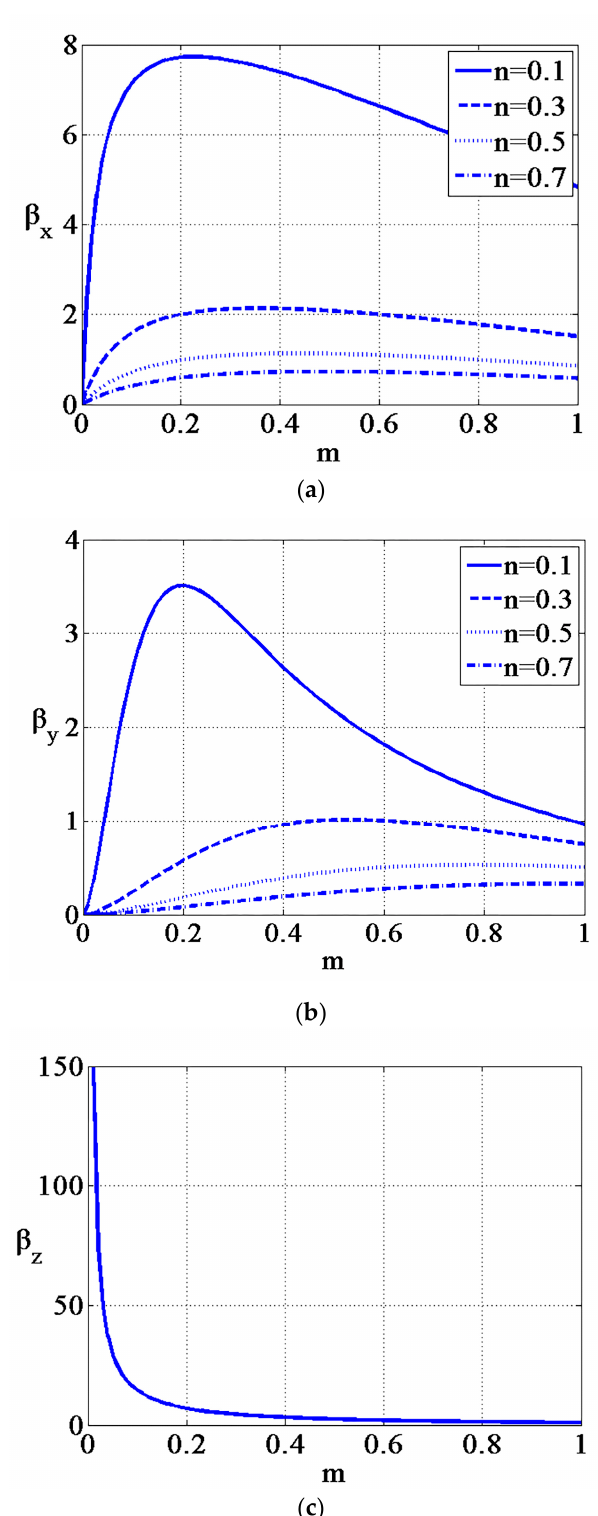
Figure 5. The relationship between parameters m , n , and the transfer coefficient: ( a ) the curve of the x-axis transfer coefficient; ( b ) the curve of the y-axis transfer coefficient; and ( c ) the curve of the z-axis transfer coefficient.